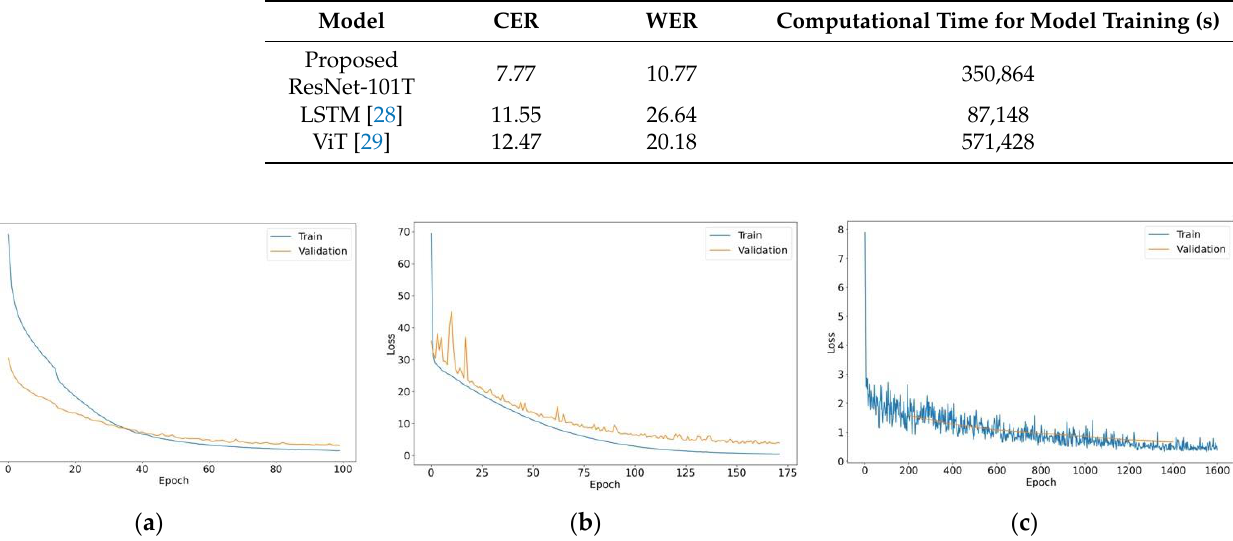
Figure 11. Experimental results of the ResNet-101T: ( a ) training and validation loss of the Transformer model; ( b ) training and validation loss of the LSTM model; ( c ) training and validation loss of ViT.